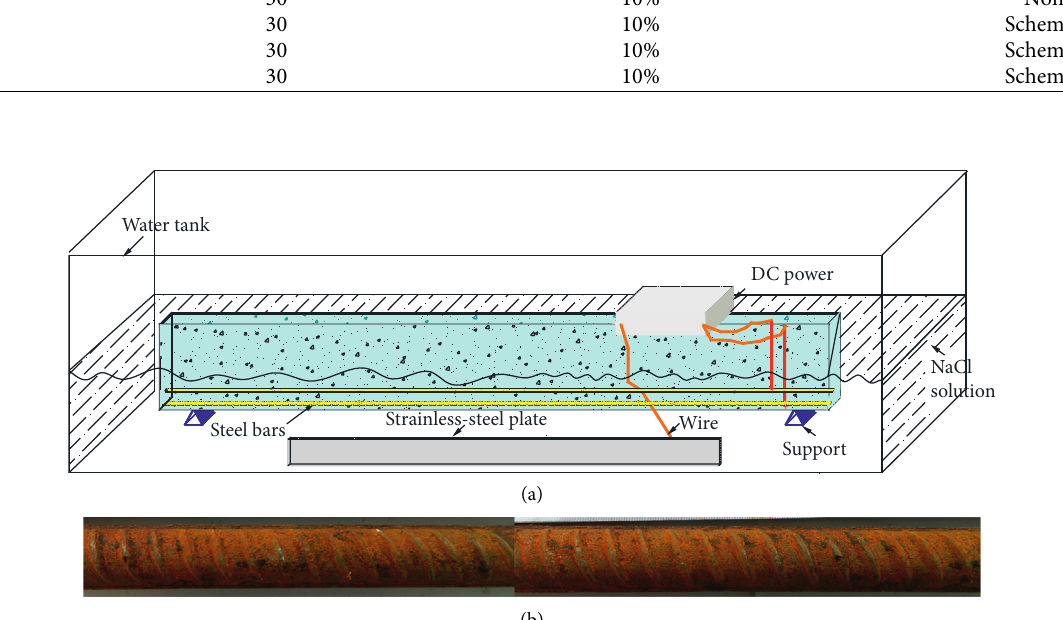
Figure 2: Corrosion of steel bar: (a) schematic diagram of accelerated corrosion of beam and (b) corroded steel